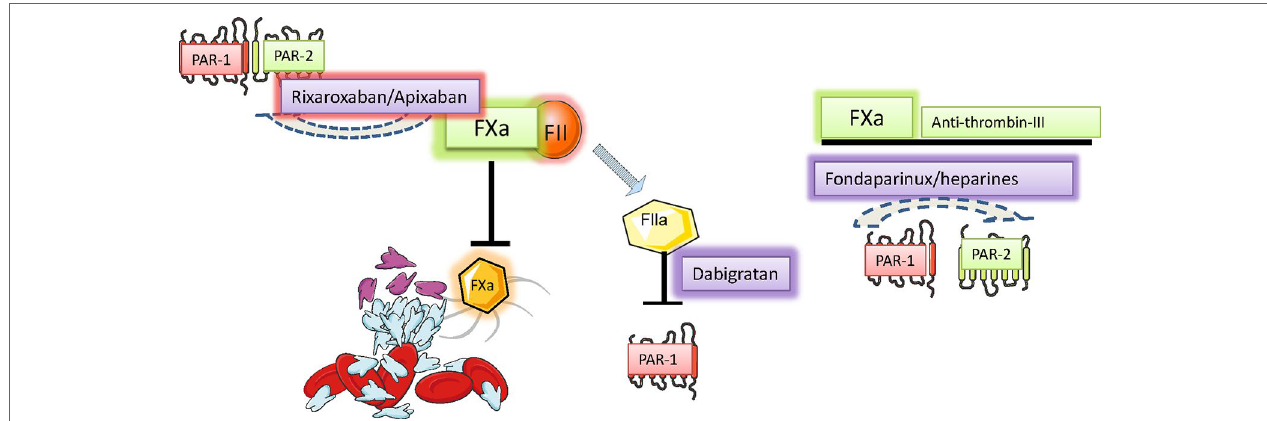
FIGURe 4 | Pharmacological strategies to control hyperacoagulability and heart inflammation. Hypercoagulability generates and sustains vascular inflammation and permeability, a condition allowing the chemotaxis of inflammatory cells to neighbor tissues. Activated Inflammatory cells secrete, among the many signals, serine proteases, and disseminate inflammation in the invaded tissue. The control of serine protease activity may be achieved pharmacologically directly and indirectly by using drugs already in use or by promising novel drugs with proved effectiveness in preclinical investigations. Figure created using Servier medical art templates.